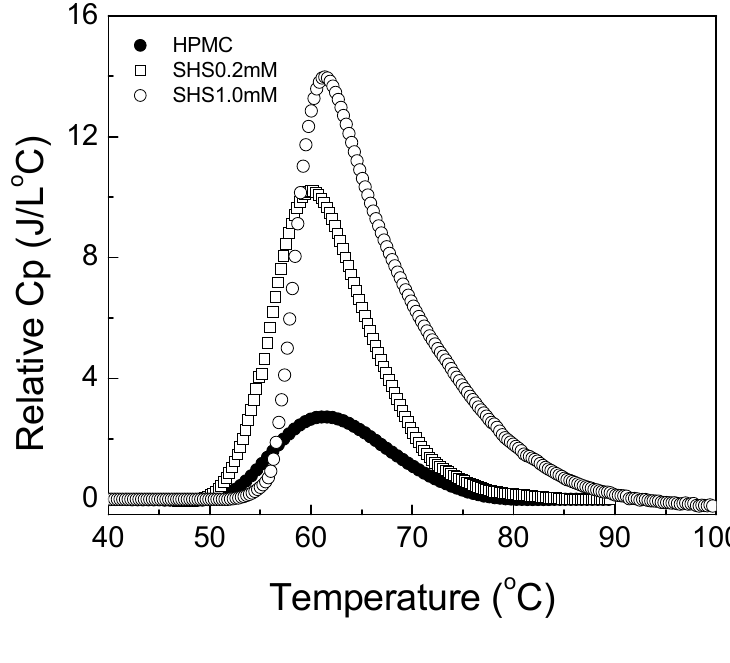
Figure 12. Relative heat capacity as a function of temperature for 1 wt% HPMC solutions with different concentrations of sodium n-hexadecyl sulfate